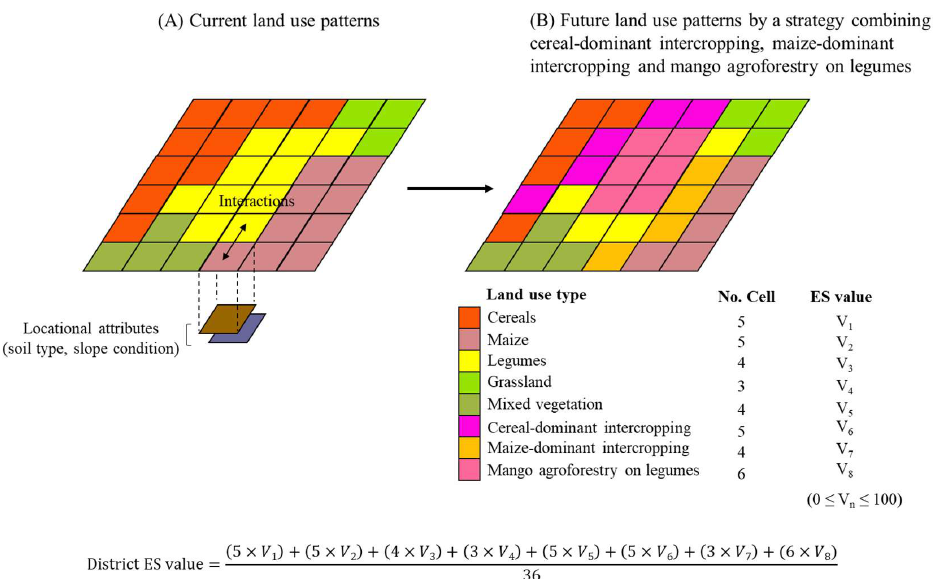
Figure 4. Generation of future land-use patterns by a land-use strategy and resultant ecosystem service values at district level. According to transition rule-sets for land-use management options (interactions with neighboring cells and locational attributes), land-use patterns are changed from A to B. An ecosystem service value at district level is calculated as a mean value for the ecosystem service supplied by each cell of changed land-use patterns.